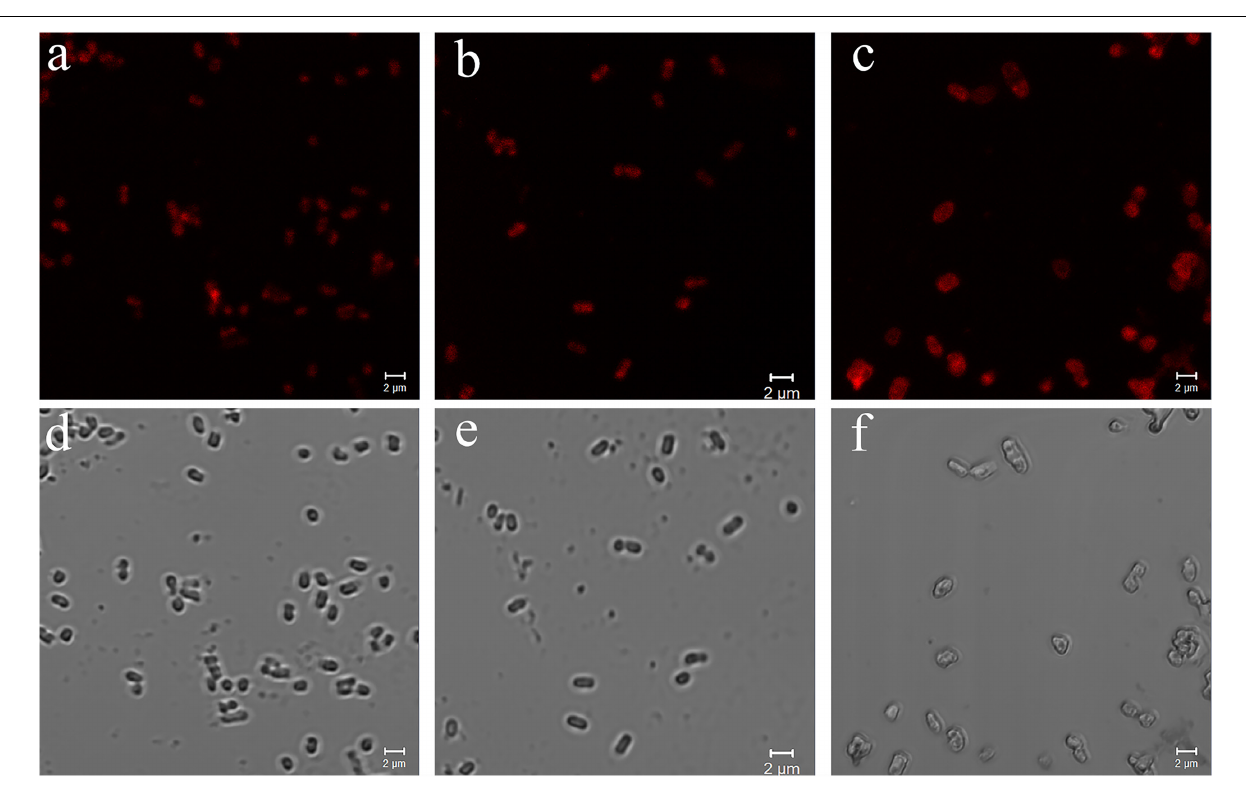
FIGURE 6 | Confocal laser scanning microscopy images of (a) Pseudomonas aeruginosa , (b) Escherichia coli , and (c) methicillin-resistant Staphylococcus aureus (MRSA) and optical images of (d) P. aeruginosa , (e) E. coli , and (f) MRSA. The strains were imaged after incubation for 30 min with PPIX-MED (15.6 µ M) in phosphate-buffered saline. Excitation was at 405 nm. Scale bars = 2 µ